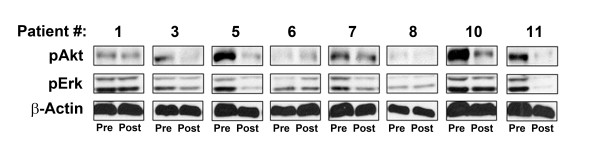
Analysis of phospho-ERK and phospho-Akt in tumor biopsies pre-treatment compared to on-therapy. Excisional biopsy material obtained prior to therapy with R115777 and during week 7 of therapy was analyzed by Western blot for the presence of phospho-Akt, phospho-Erk, and total β-Actin.